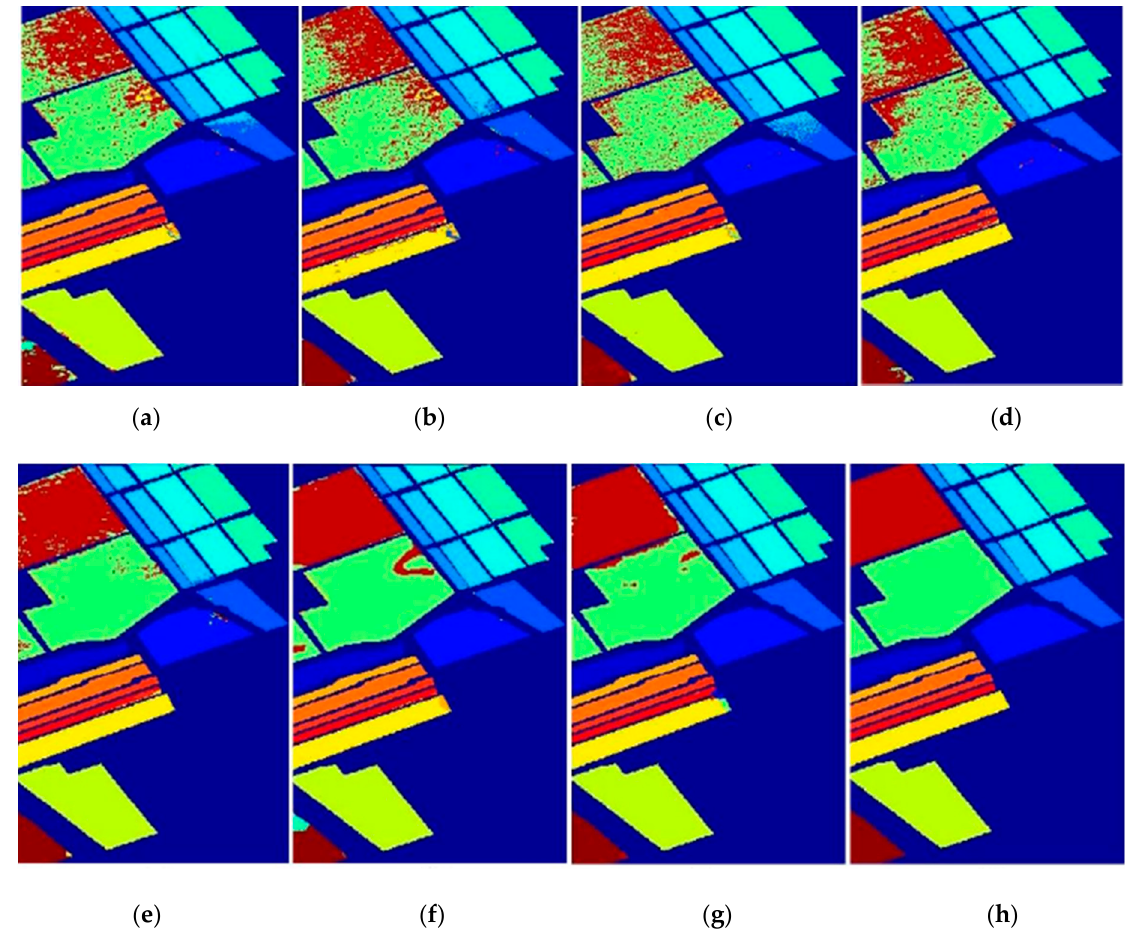
Figure 7. Classification map of the Salinas data set with 30 samples: ( a ) ELM, ( b ) KELM, ( c ) WKELM, ( d ) SS-KELM, ( e ) KELM-CK, ( f ) ASS-H-DELM, ( g ) HCKBoost, ( h ) and DW-KELM.